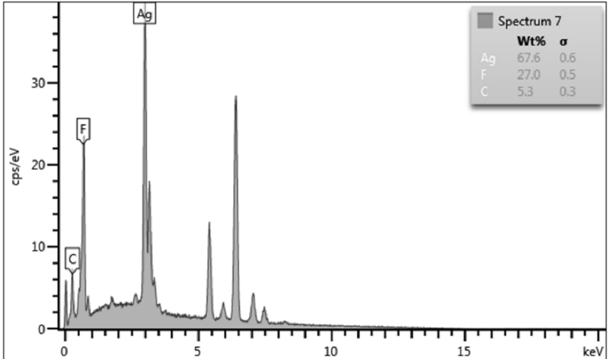
Figure 4. An illustration of EDS output for silver (Ag), fluorine (F), and carbon (C), shown in pre-normalised wt % format.